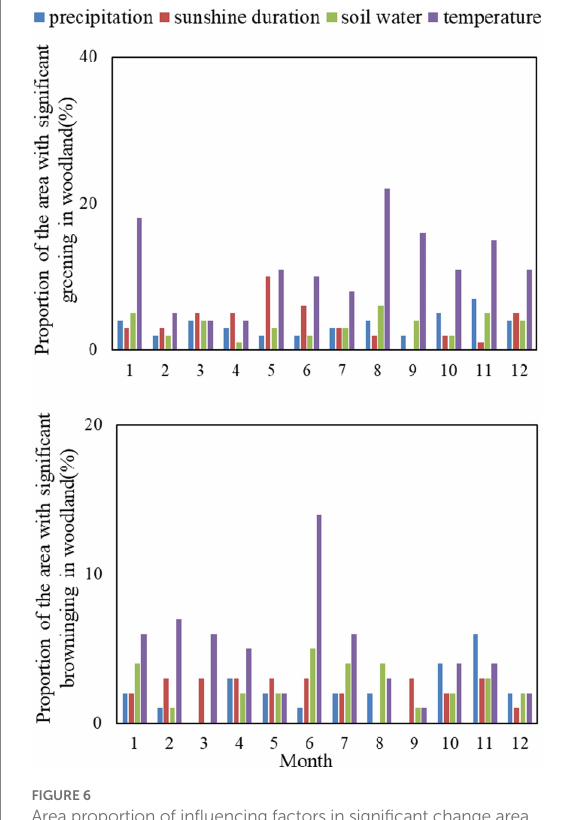
FIGURE 7 Area proportion of influencing factors in significant change area of